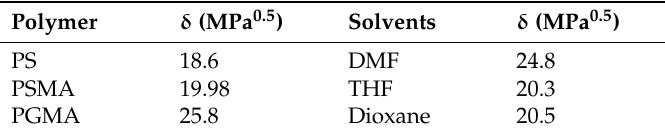
Table 2. Solubility parameters of solvents and homopolymers. DMF: N,N -dimethylformamide.